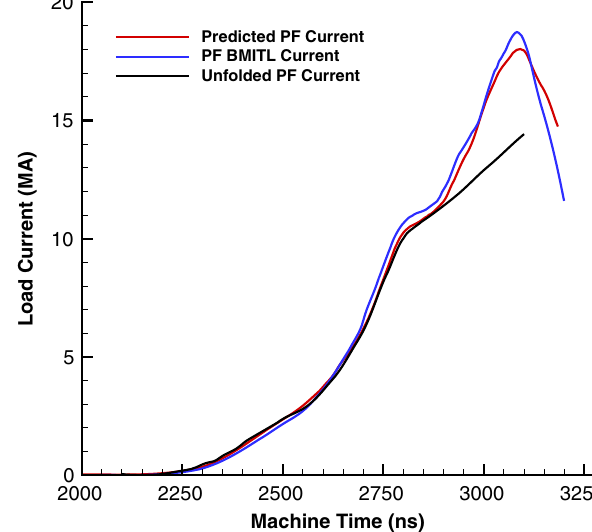
FIG. 3. Plot of predicted current and associated load inductance for the PF design compared to a reference DMP design.